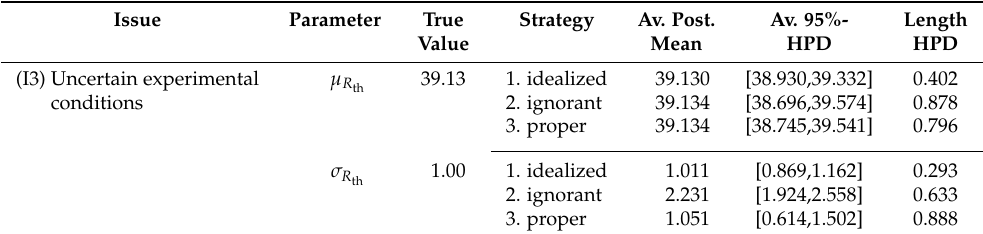
Table 2. Simulation results for Issue 3 (I3, Section 4.4) based on experiments E3.a–E3.c. Averaged posterior means (Av. post. mean) for µ R regions (Av. 95%-HPD) for µ R (Length HPD) over 100 datasets based on n = 100